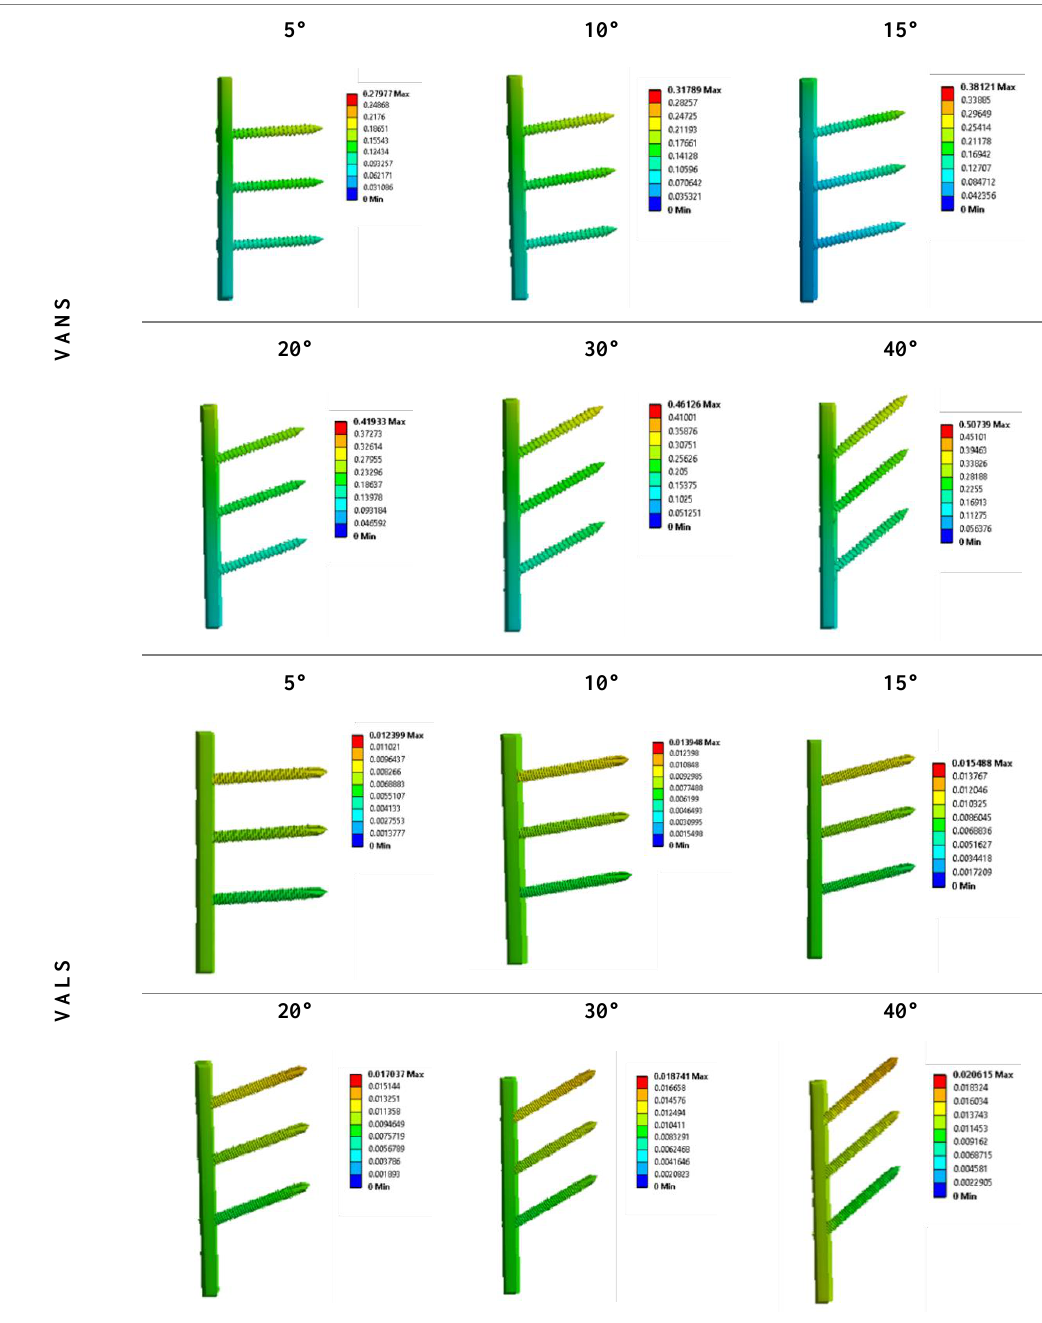
Figure A17. Total displacement (mm) of the PHILOS construct with VALS and VANS at upward angles (5°, 10°, 15°, 20°, 30°, 40°) to the neutral axis.